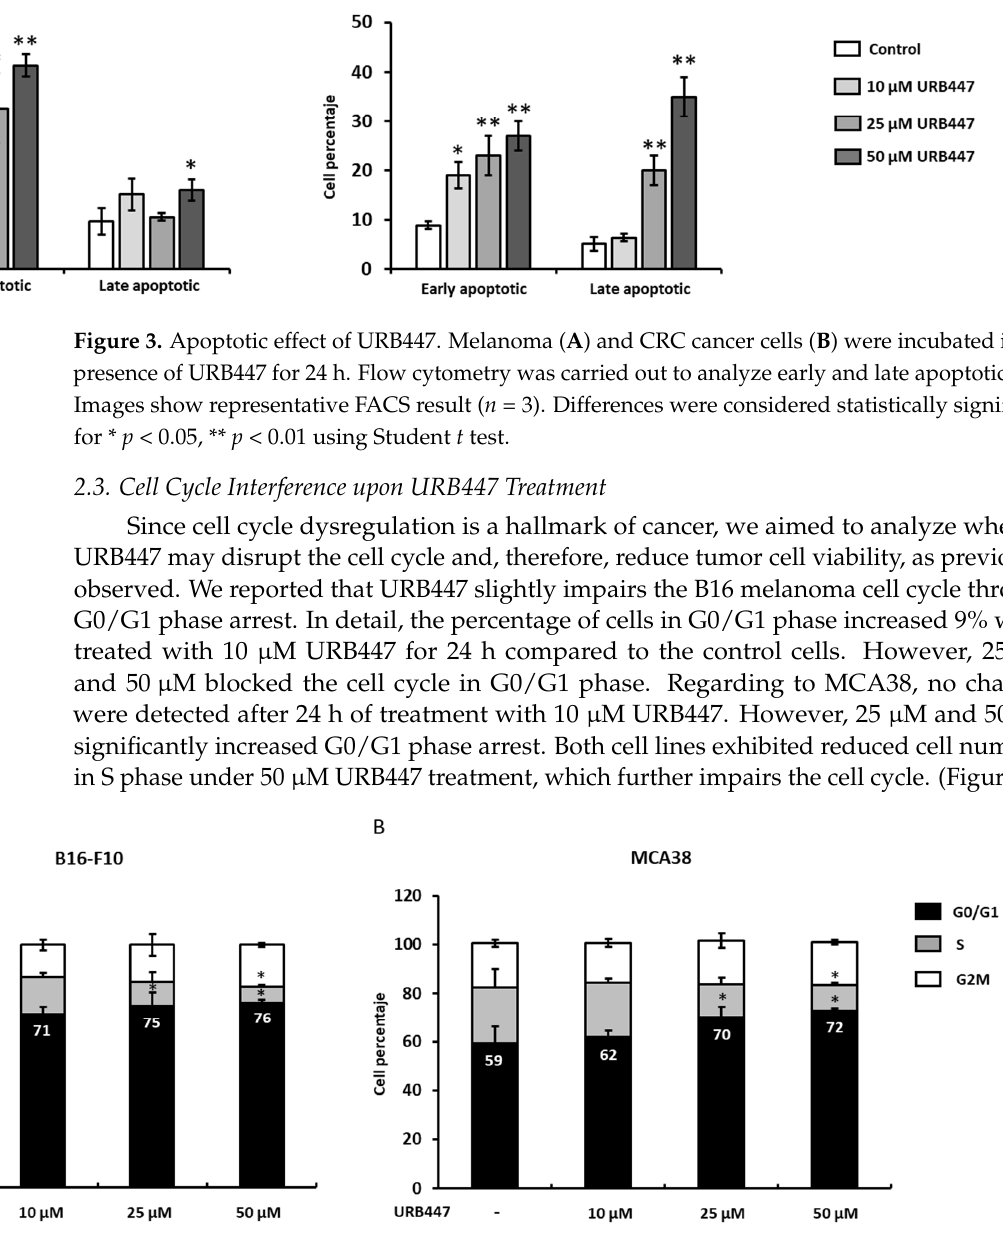
Figure 4. Cell cycle analysis in cells treated with URB447. Melanoma ( A ) and CRC cancer cells ( B ) were incubated in the presence of different concentrations of URB447 for 24 h. Propidium iodide RNAse Kit was used for flow cytometry and the number of cells in each cell cycle phase were quantified ( n = 3). Differences were considered statistically significant for * p < 0.05 using Student t test.